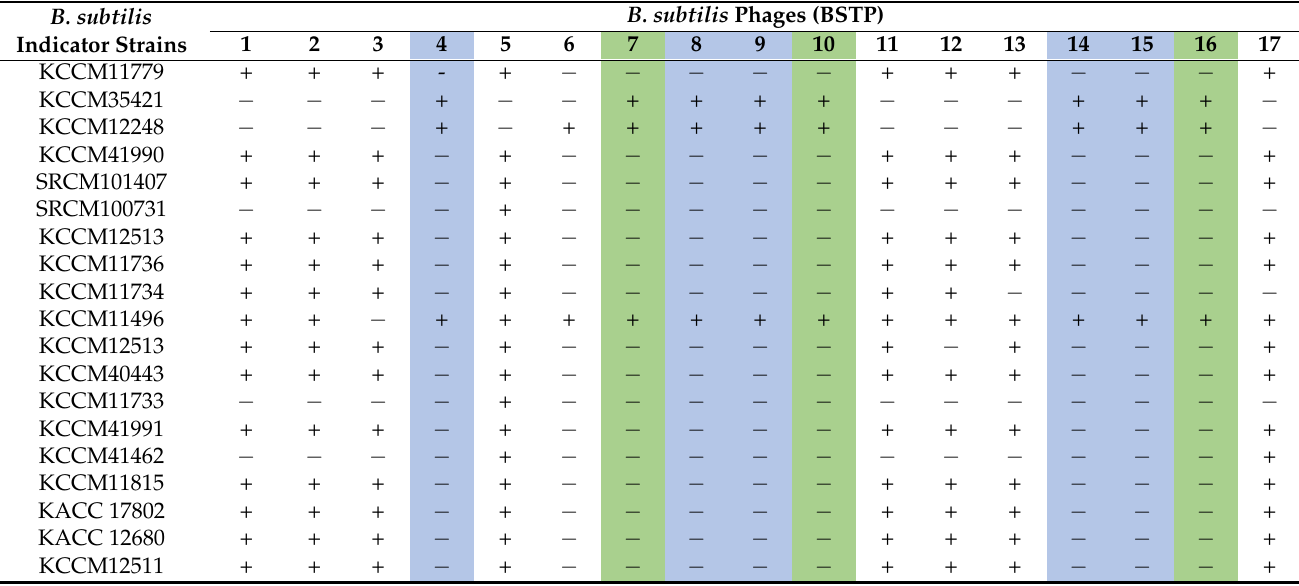
Table 4. Phage host range analysis of B. subtilis phages on 28 B. subtilis indicator